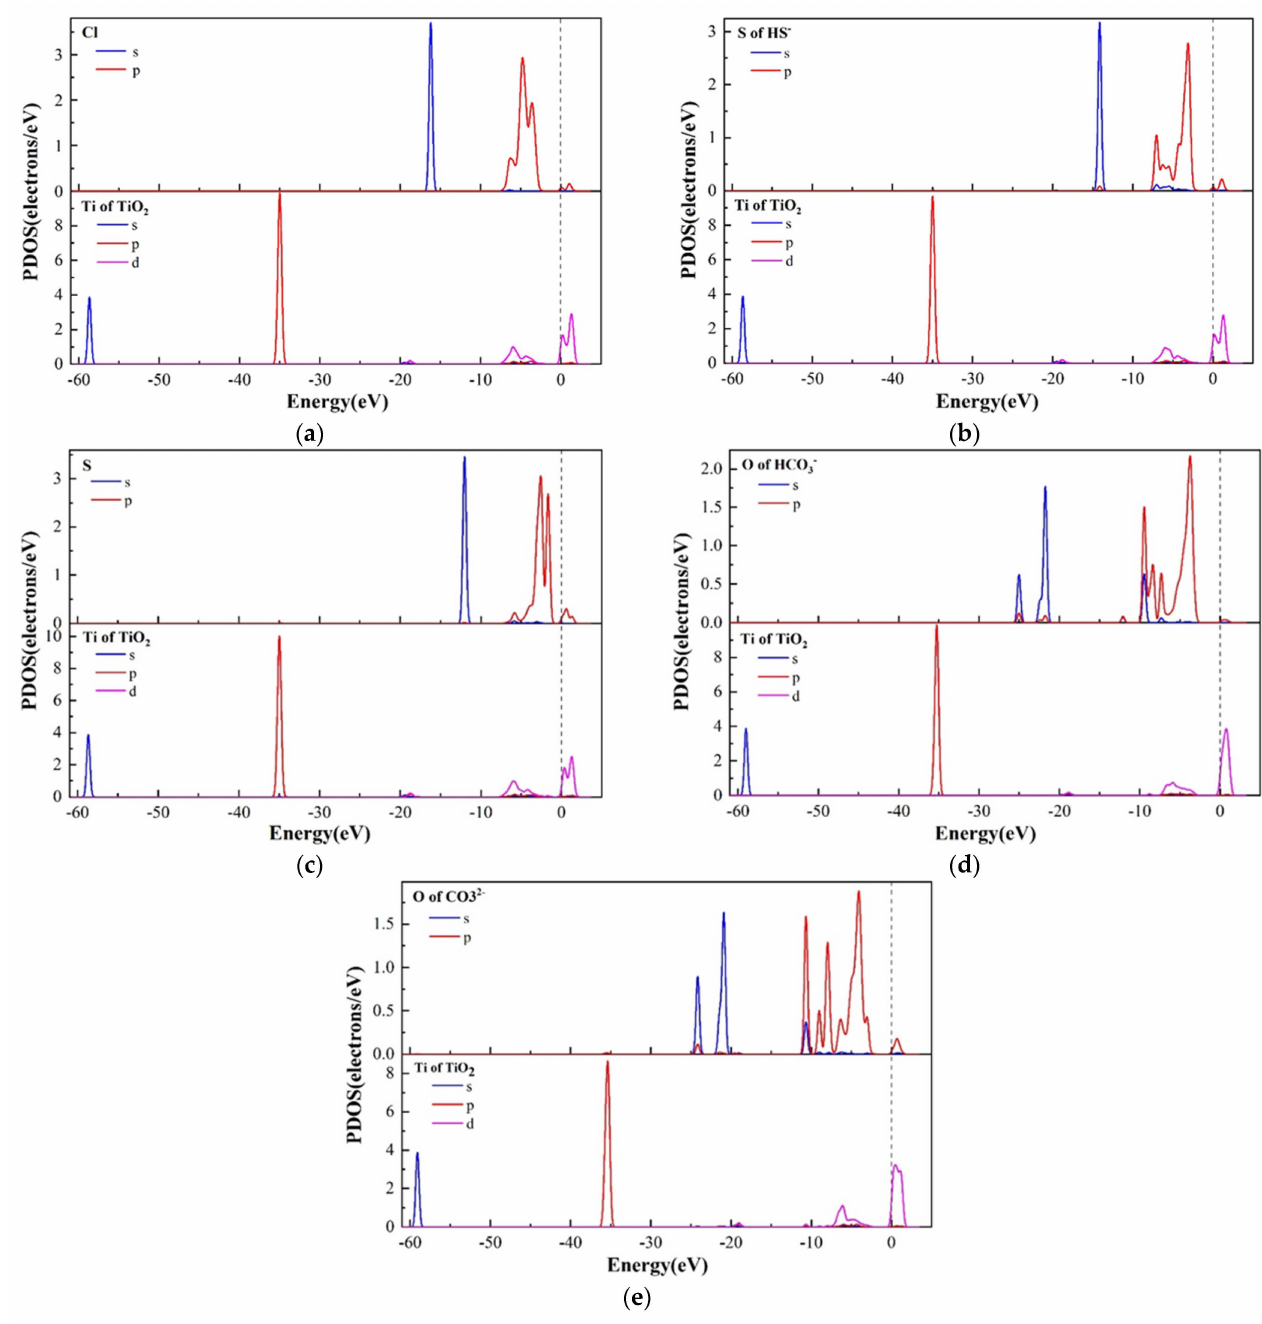
Figure 5. PDOS curves of corrosive species adsorbed on the bridge position of the TiO 2 (110) surface (note: the valence electrons of Cl, S, O and Ti are 3S 2 3P 5 , 3S 2 3P 4 , 2S 2 2P 4 and 3p 6 3d 2 4s 2 , respectively): ( a ) Cl − ; ( b ) HS − ; ( c ) S 2 − ; ( d ) HCO 3 − ; ( e ) CO 32 −